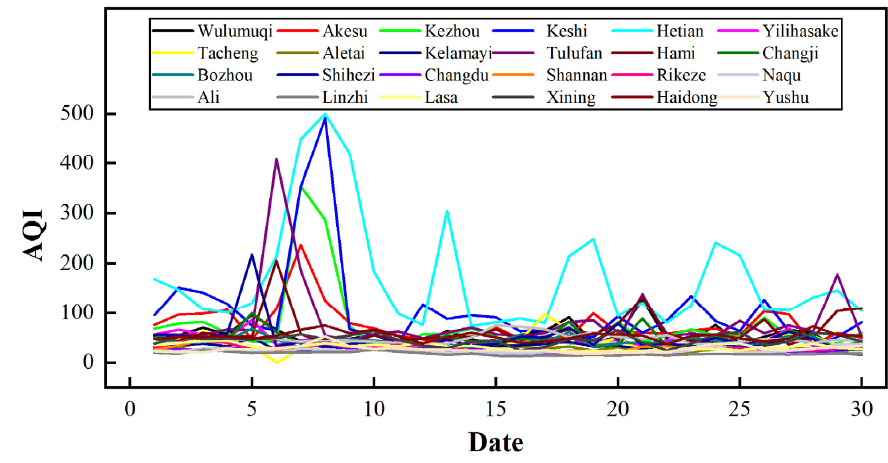
Figure 9. Average daily AQI for selected cities in western China in June 2020.